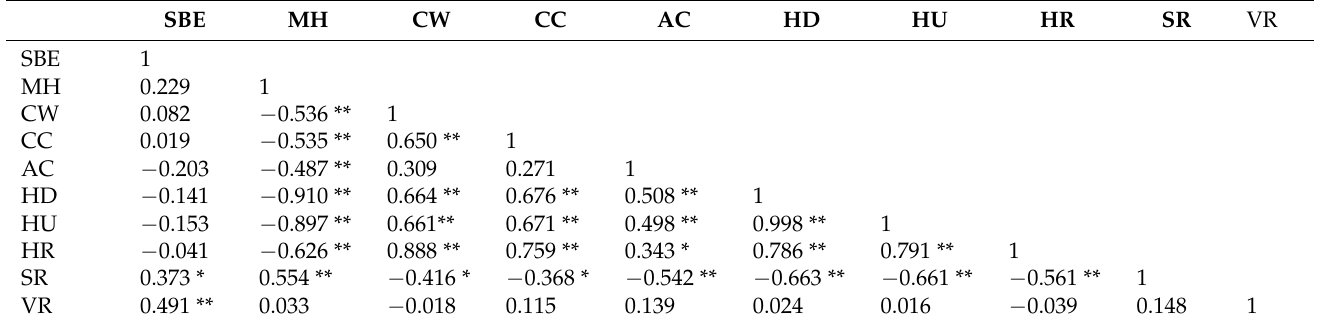
Figure 3. SBE in different types of vegetation. Different lowercase letters (a, b, ab, c) in the figure indicate significant differences in SBE of different vegetation types ( p < 0.05).